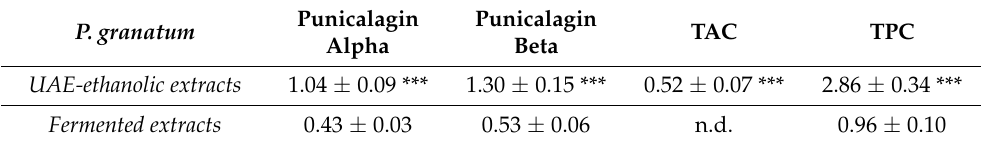
Table 4. Content of punicalagin alpha and beta, total anthocyanins content (TAC), and total